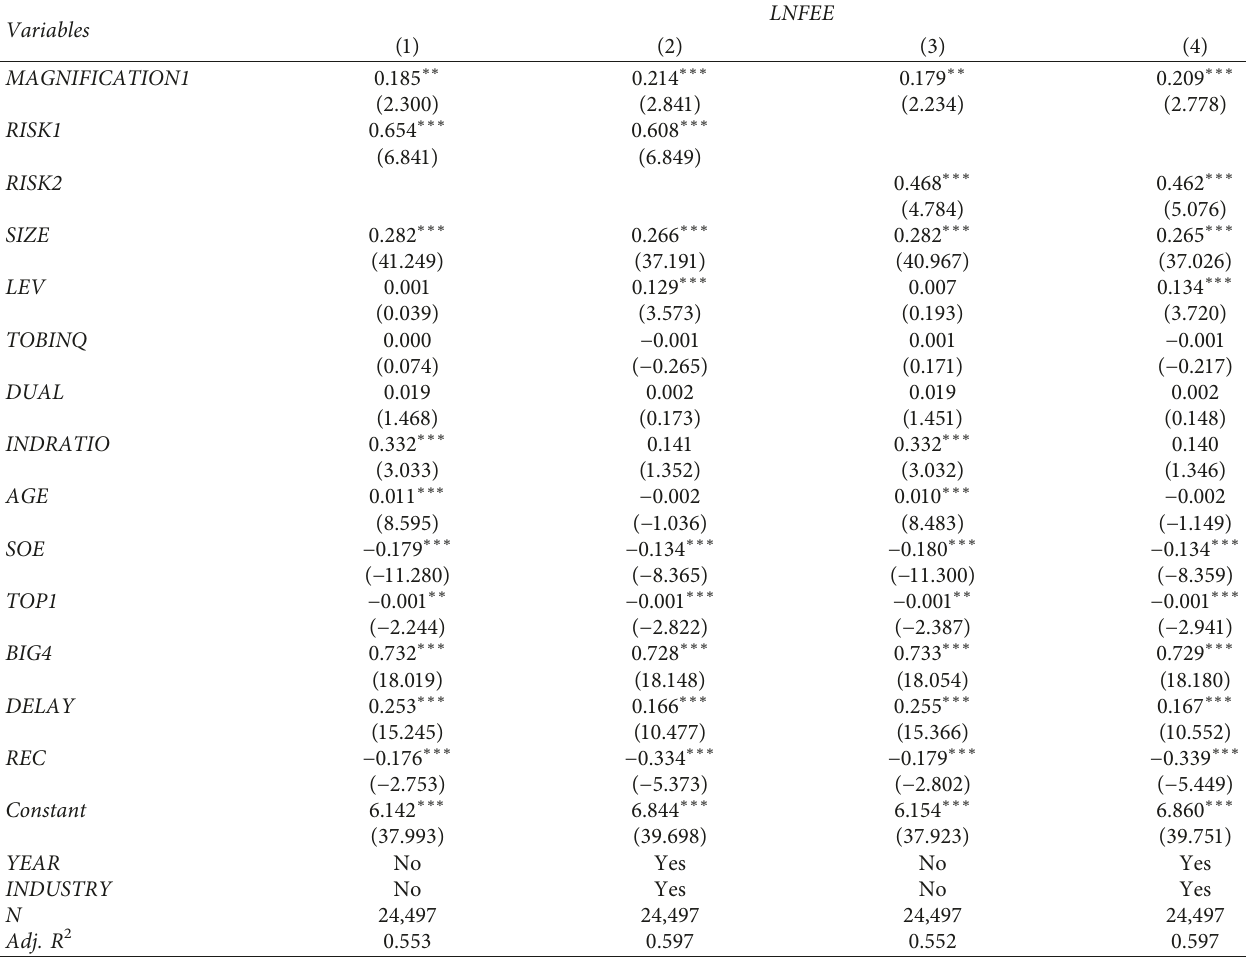
Table 7: The impact of amplification effect and audit risk on audit